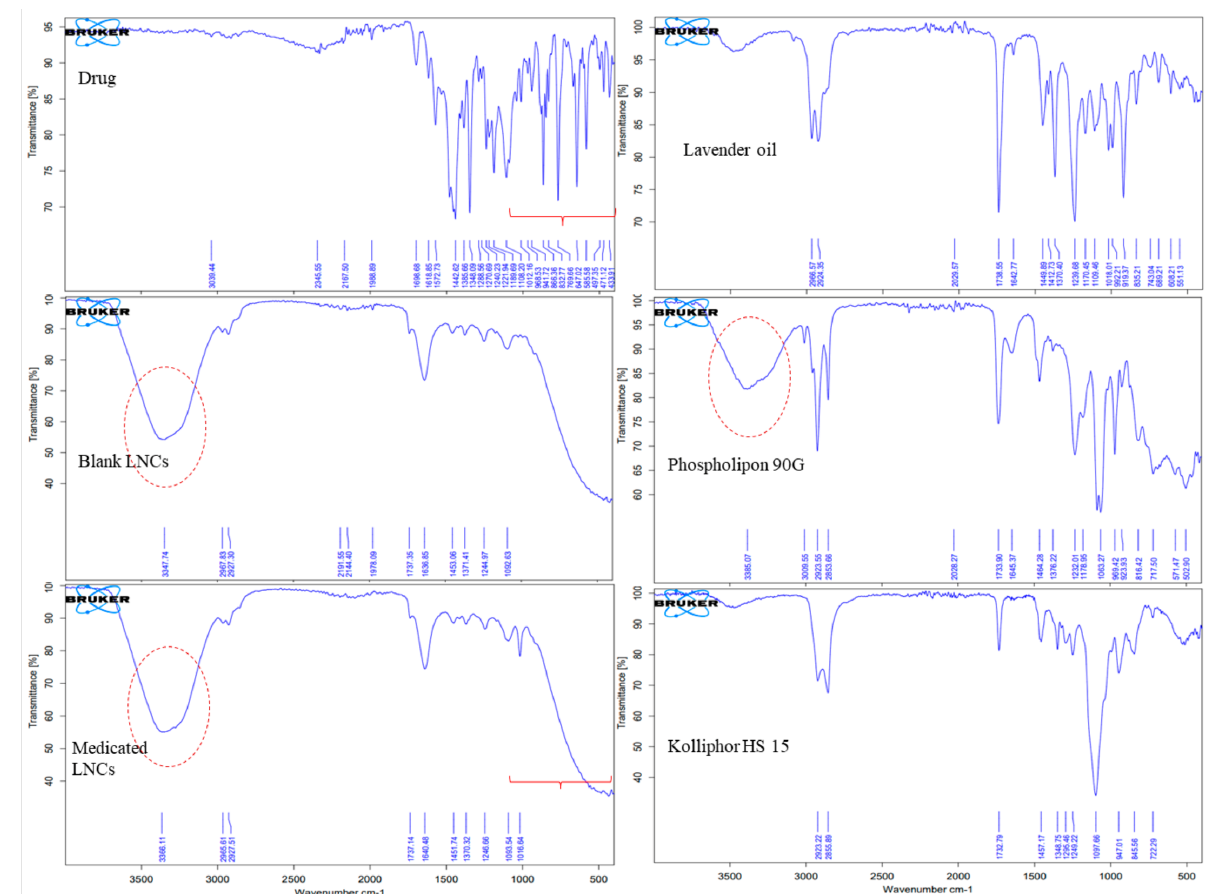
Figure 7. FTIR spectra of the drug, excipients, and blank and loaded LNCs (F22-AS). Asenapine’s spectrum displayed distinctive bands at 3039 cm − 1 (representing aromatic C–H) 1698 cm − 1 (for C=O stretching), 1572 cm − 1 (C=C stretching vibration), 1442 cm − 1 (C–C stretching), 1348 cm − 1 (C–N stretching), 1189 cm − 1 (C–O stretching), and 760 cm − 1 (C–O stretching and C–Cl stretching)